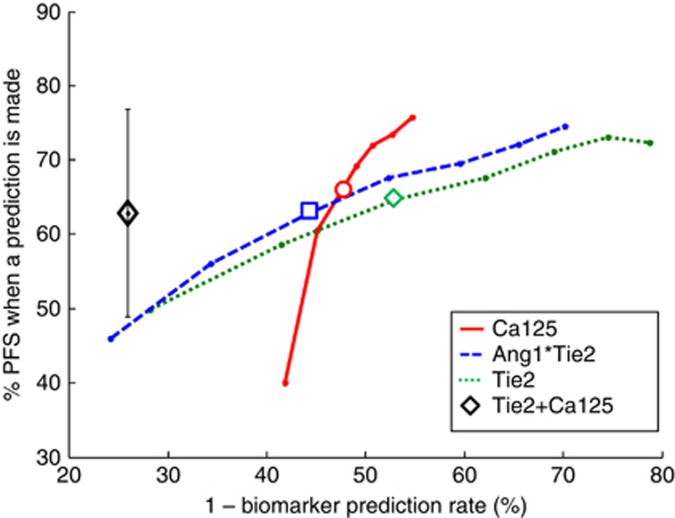
Tie2 in combination with Ca125 provides better prediction on tumour progression.The performance of Tie2, Ang1 × Tie2 and Ca125 as biomarkers for predicting tumour progression is shown. 1–biomarker prediction rate is plotted against percentage of PFS time when a prediction is made. Data points close to the top left corner indicate superior performance. The red solid line represents the performance of using Ca125 and the GCIG criteria are shown as a red circle. The green dashed line and the blue dotted line represent the performance of Tie2 and Ang1 × Tie2 as resistance biomarkers, respectively. The highlighted dots on these lines correspond to using 50% elevation from nadir points as criteria for prediction. It demonstrated that if Tie2 was used in conjunction with Ca125, a better prediction can be made compared with using either one alone, as indicated by the black diamond. The combination of Tie2 and Ca125 predicted tumour progression in 74.1% of patients at an average of 62.8%±14.1 %PFS time.